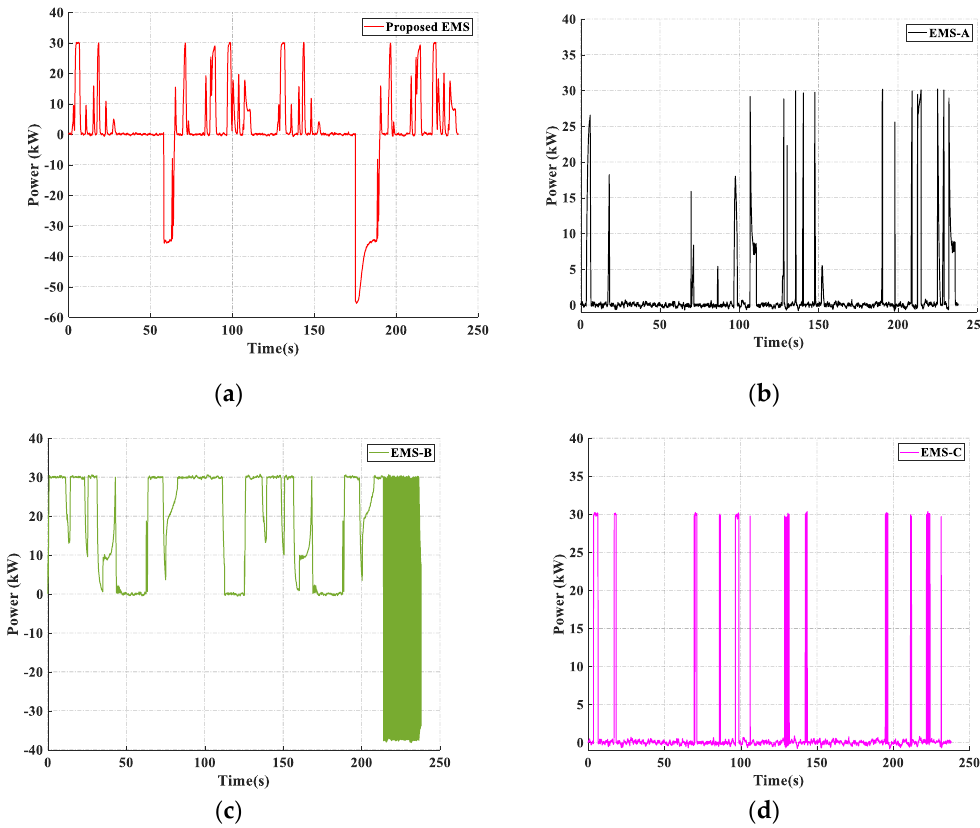
Figure 19. Power from the battery in the proposed case and conventional cases. ( a ) Proposed EMS; ( b ) EMS-A; ( c ) EMS-B; ( d ) EMS-C.